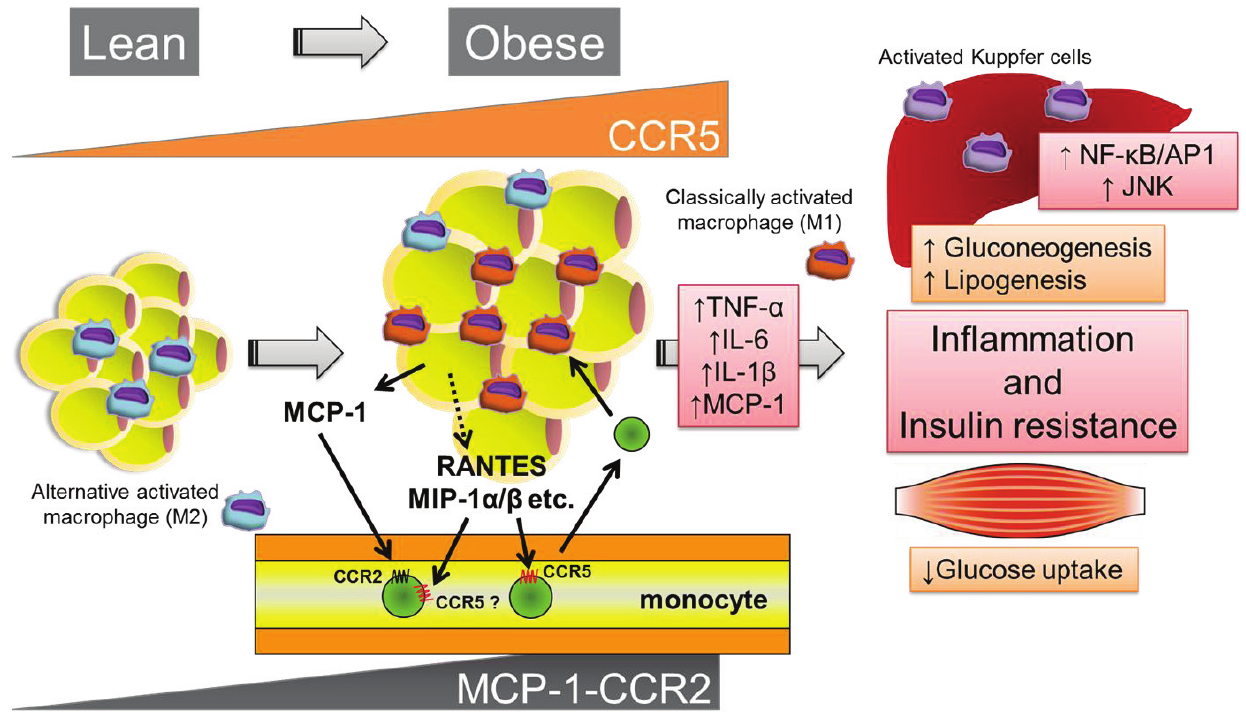
Figure 1. CCR5 promotes obesity-induced inflammation and insulin resistance. In a